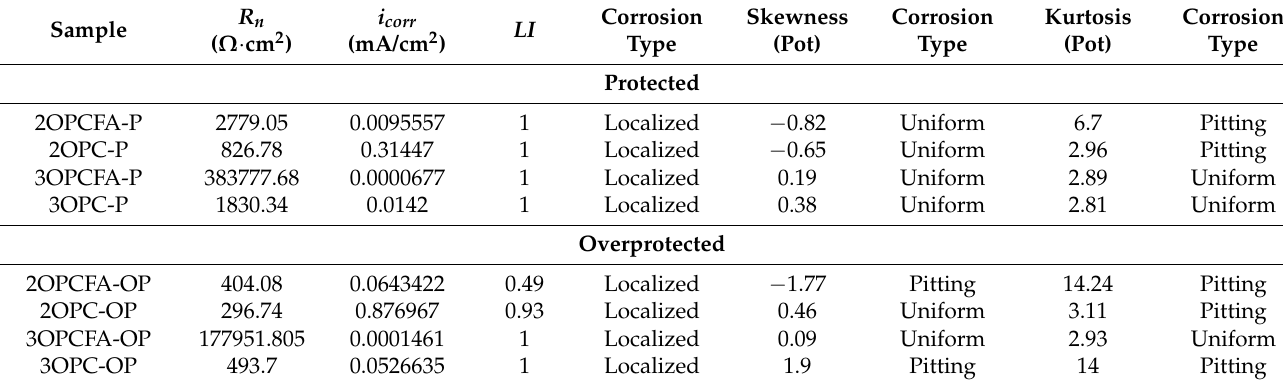
Table 5. EN statistical parameters of specimens subjected to Impressed current cathodic protection of reinforced concrete mixtures (OPC-P/OP and